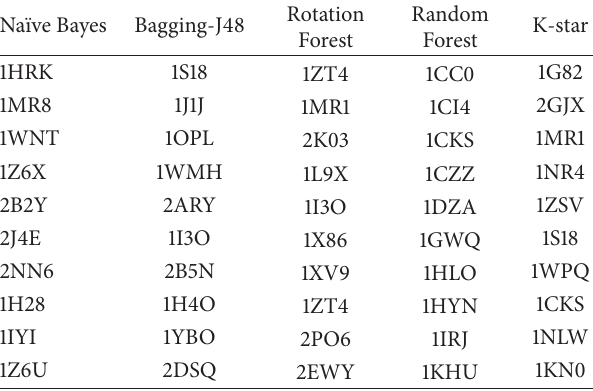
Table 2: Ten best putative candidate predictions with a probability of 1, from all five machine learning algorithms